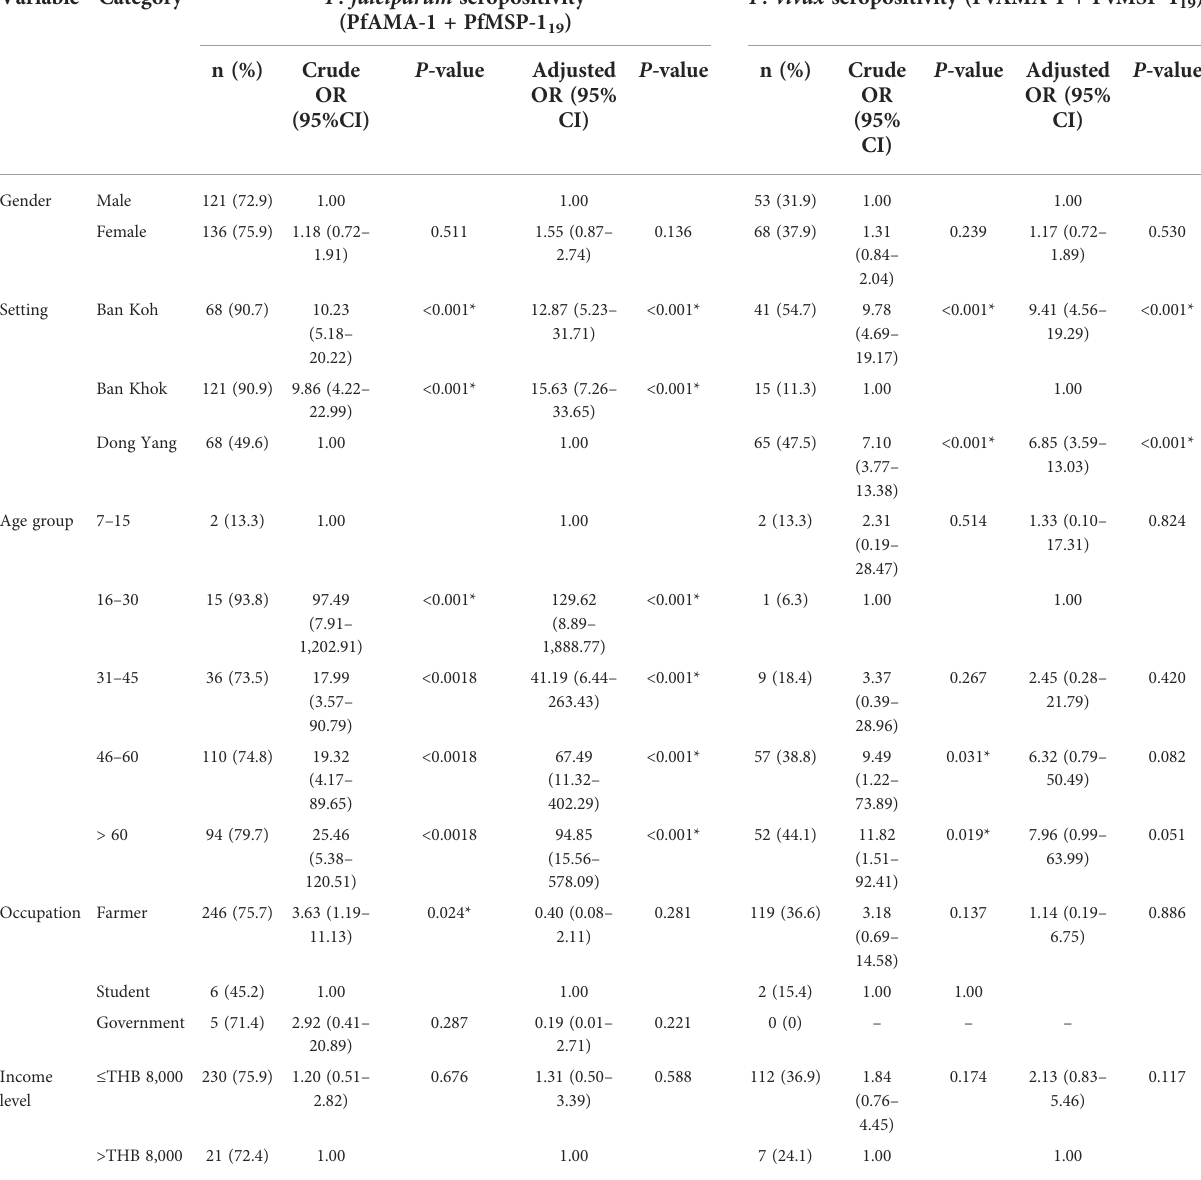
TABLE 4 Logistic regression analyses of seropositivity to any P. falciparum – and P. vivax – speci fi c antigens in Mukdahan Province, Northeastern Thailand. Variable